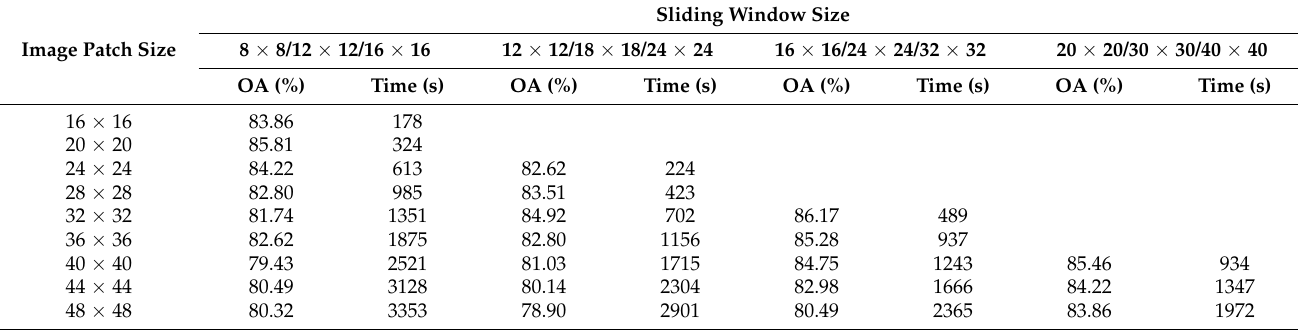
Table 3. Overall accuracy and time consumption using different combinations of image patch size and sliding window size.